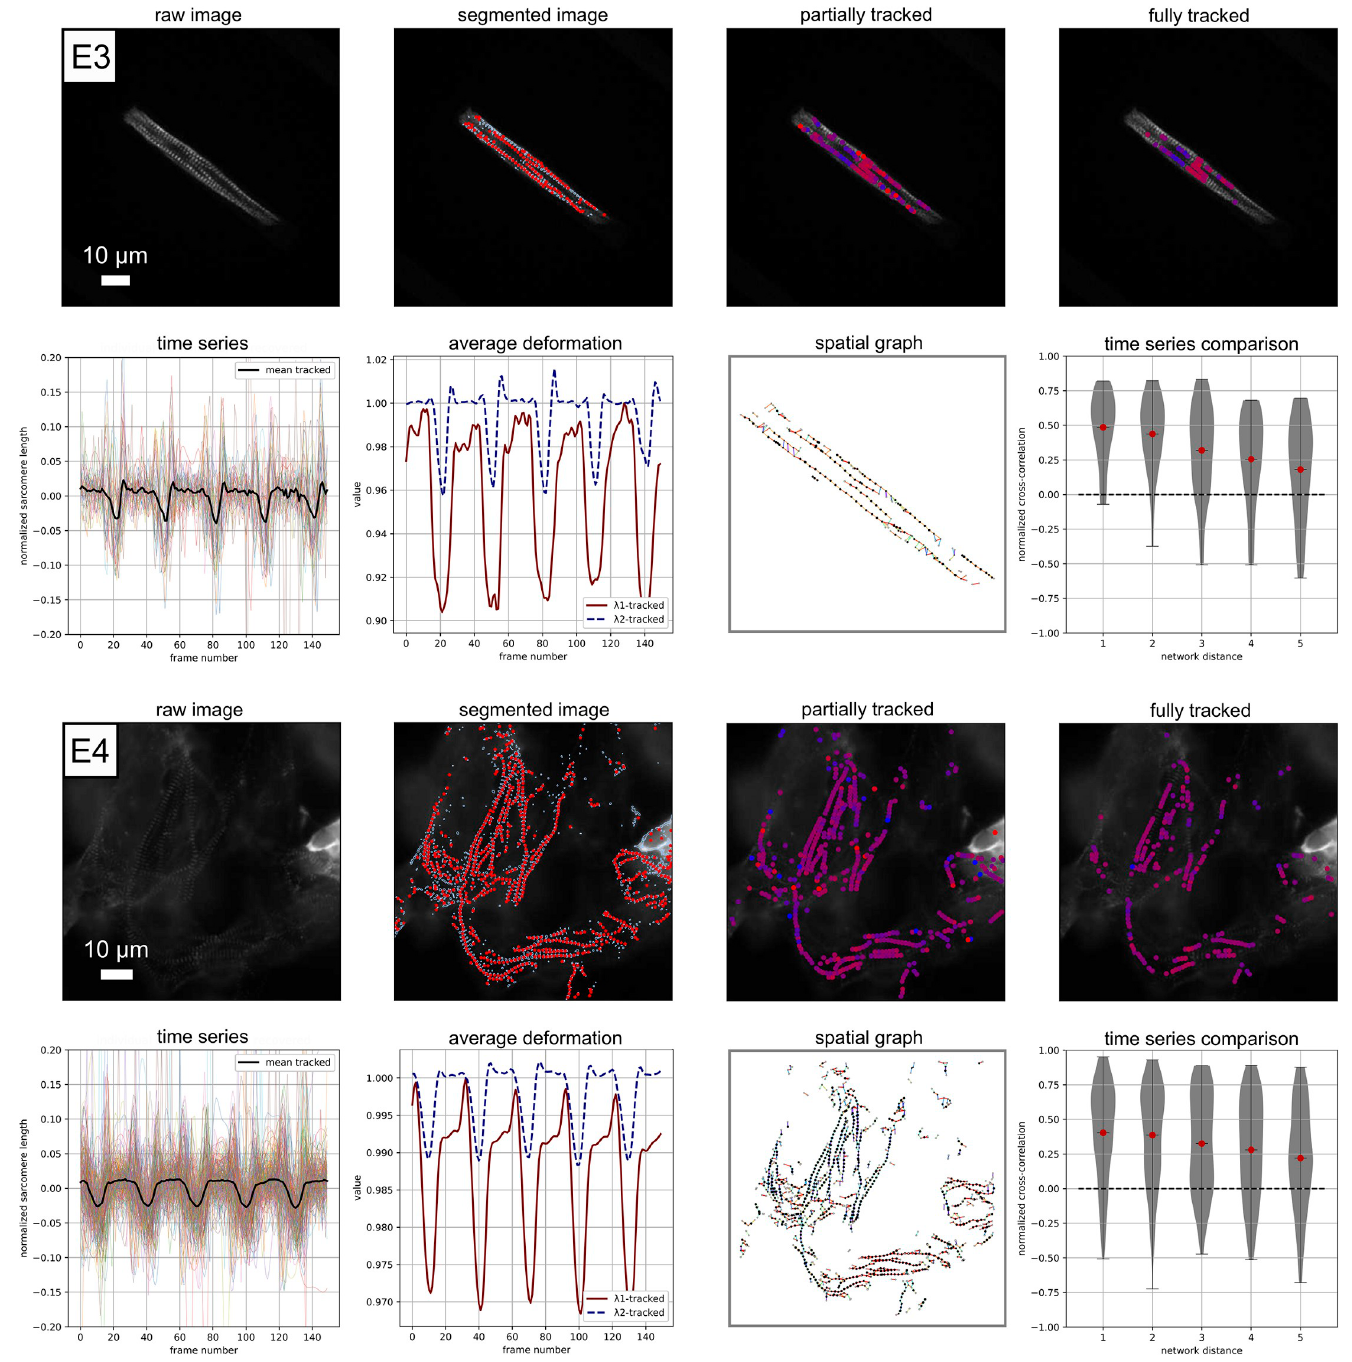
Fig 8. Example performance on experimental data E3 and E4: Raw image visualization; z-disc and sarcomere segmentation; Sarcomeres that are tracked for 1/3 or more of the movie, red corresponds to a contracted state, blue corresponds to a relaxed state (frame 50 for E3, frame 40 for E4); Sarcomeres that are tracked for 3/4 or more of the movie, red corresponds to a contracted state, blue corresponds to a relaxed state (frame 50 for E3, frame 40 for E4), note that these sarcomeres are included in the time series analysis; Individual time series data for normalized sarcomere length; Average deformation behavior; Illustration of the data represented as a spatial graph, color corresponds to sarcomere orientation; Normalized sarcomere time series cross-correlation score plotted as a function of the distance along the network. S3 and S4 Movies are included for further visualization.